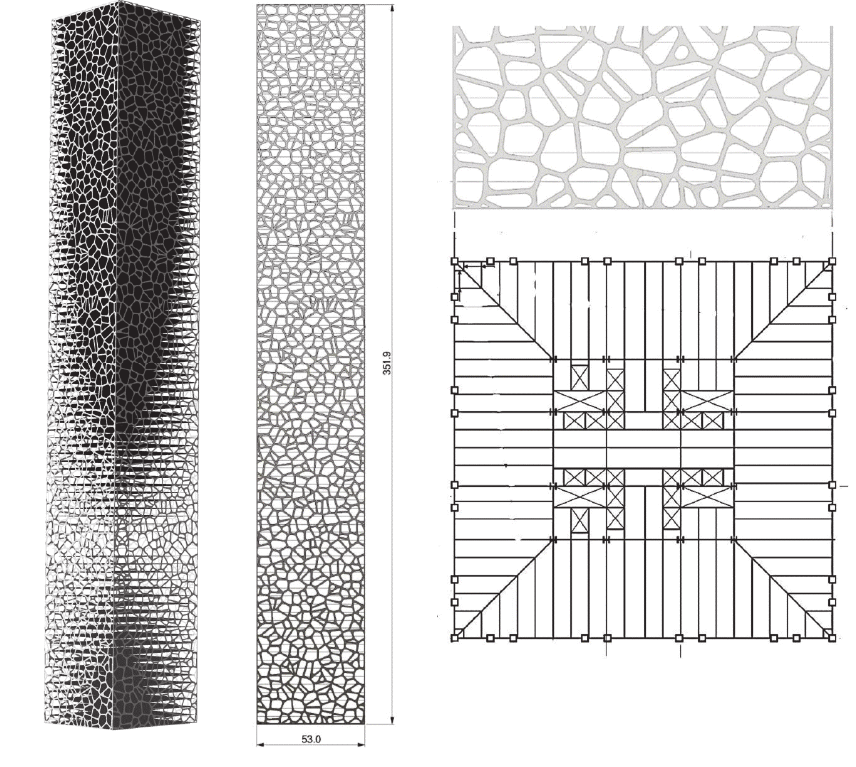
Figure 21: Voronoi building model, elevation and plan.